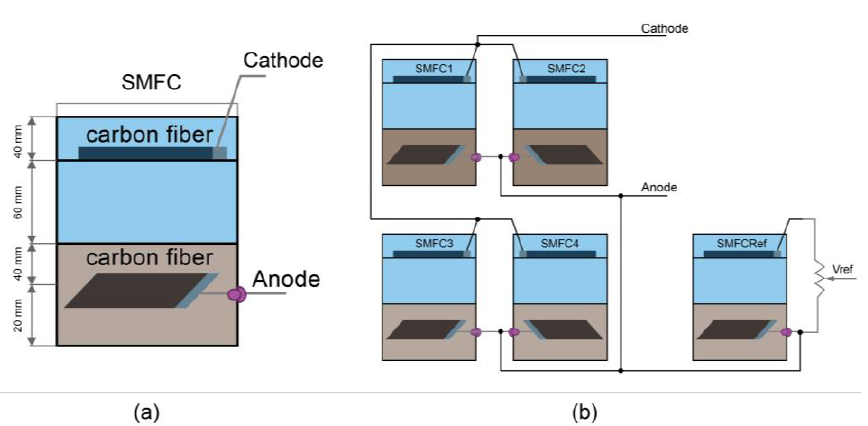
Figure 1. ( a ) Schematic sediment microbial fuel cell diagram. ( b ) Topology of the SMFCs arrangement: four SMFCs connected in parallel and the SMFC Ref .